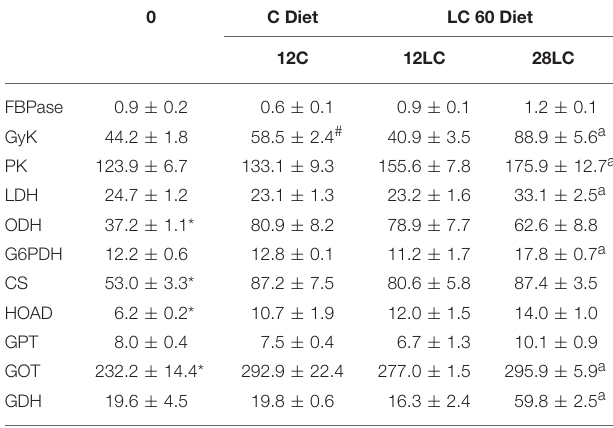
FIGURE 1 | Time course of the ratio between glutamate pyruvate transaminase and citrate synthase (GPT/CS), and β -hydroxyacyl CoA dehydrogenase and citrate synthase (HOAD/CS) activities in octopus paralarvae from Experiment 1. Different superscripts indicate significant differences between sampling points for each parameter ( n = 3).